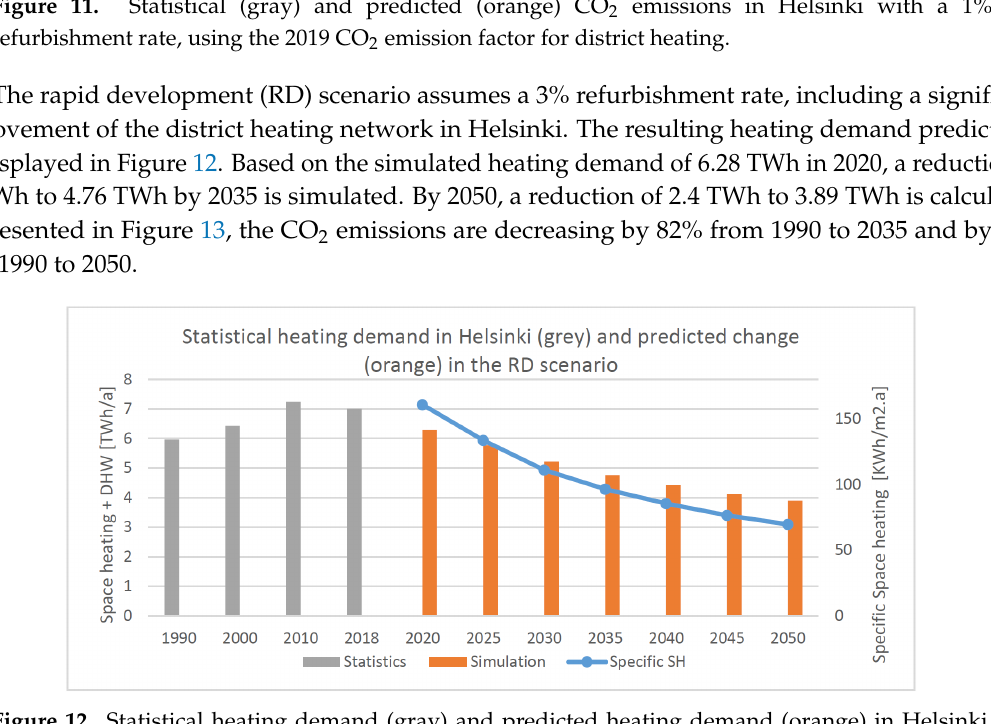
Figure 12. Statistical heating demand (gray) and predicted heating demand (orange) in Helsinki, assuming a 3% refurbishment rate for the actual building